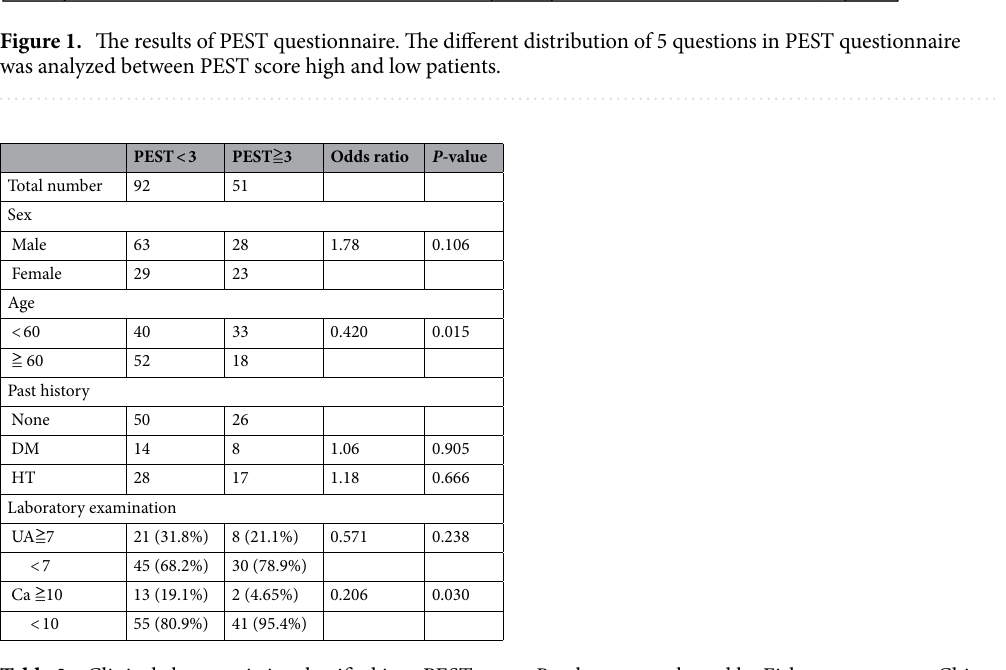
Table 3. Clinical characteristics classified into PEST score. P -value was evaluated by Fisher exact test or Chi- square test.